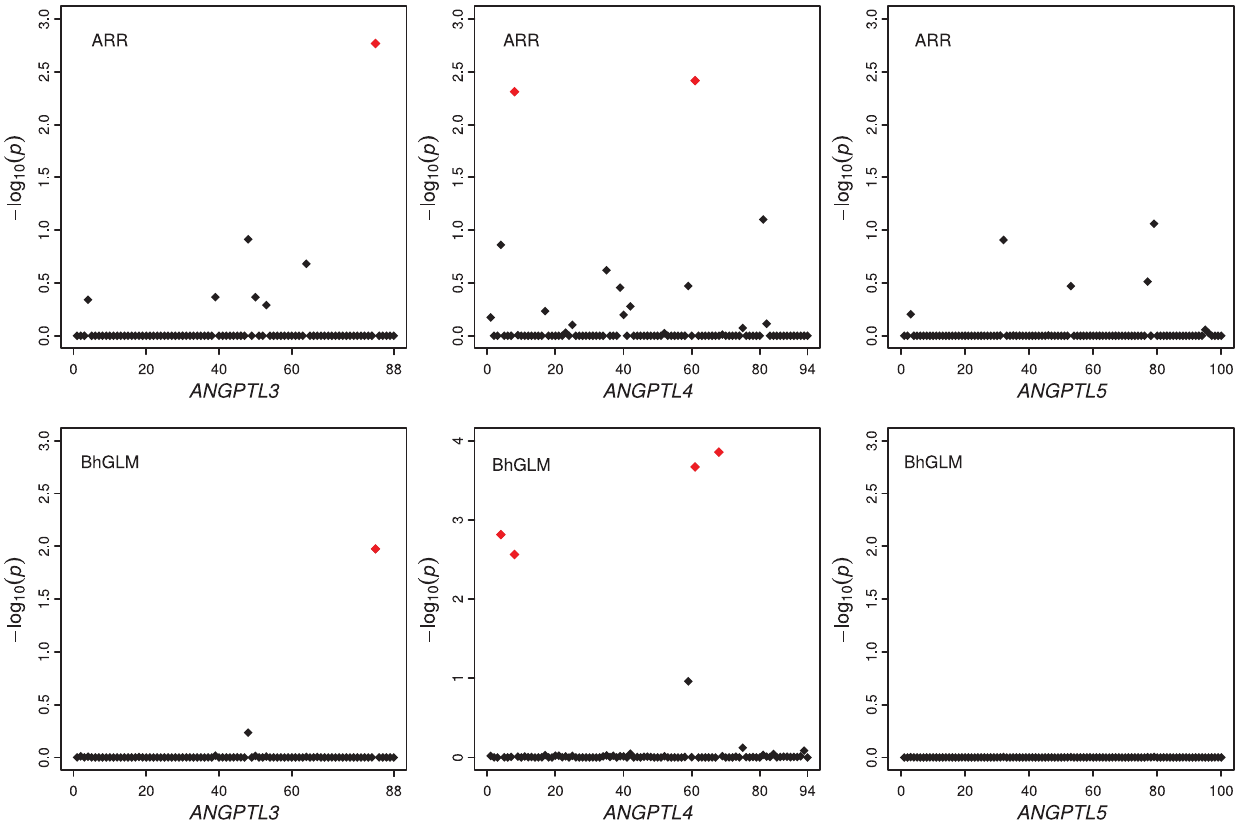
Figure 1. Significance level for each marker in ANGPTL3 , ANGPTL4 and ANGPTL5 generated from the joint analyses. P value is shown on the –log 10 scale. The top panels show the result of the adaptive ridge regression (ARR) analysis and the bottom panels show the results of the Bayesian hierarchical generalized linear model (BhGLM) analysis. The red dots represent variants with p -values smaller than 0.05, i.e., { log w 1 : 301 . 10 ( p )